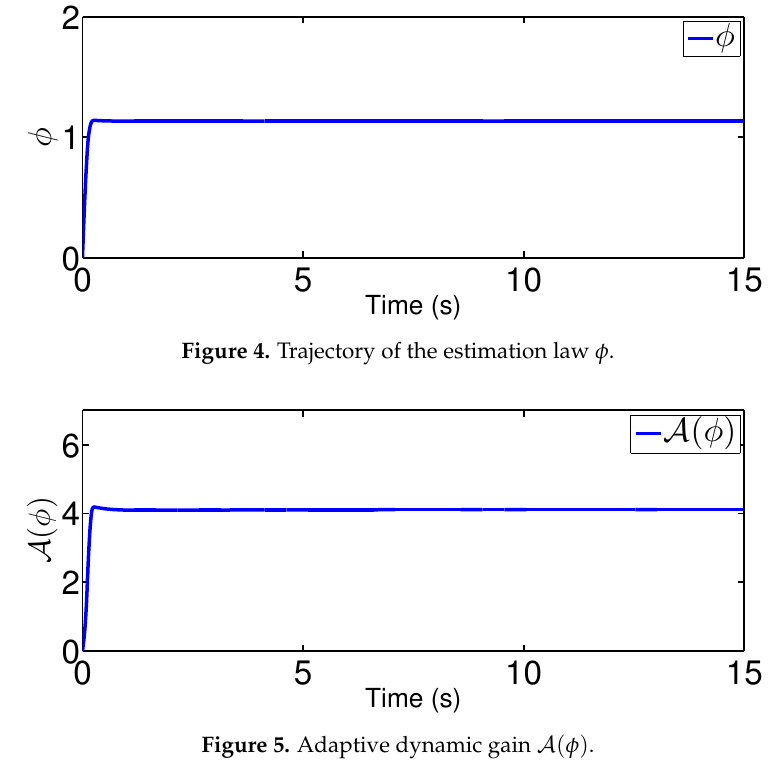
Figure 5. Adaptive dynamic gain